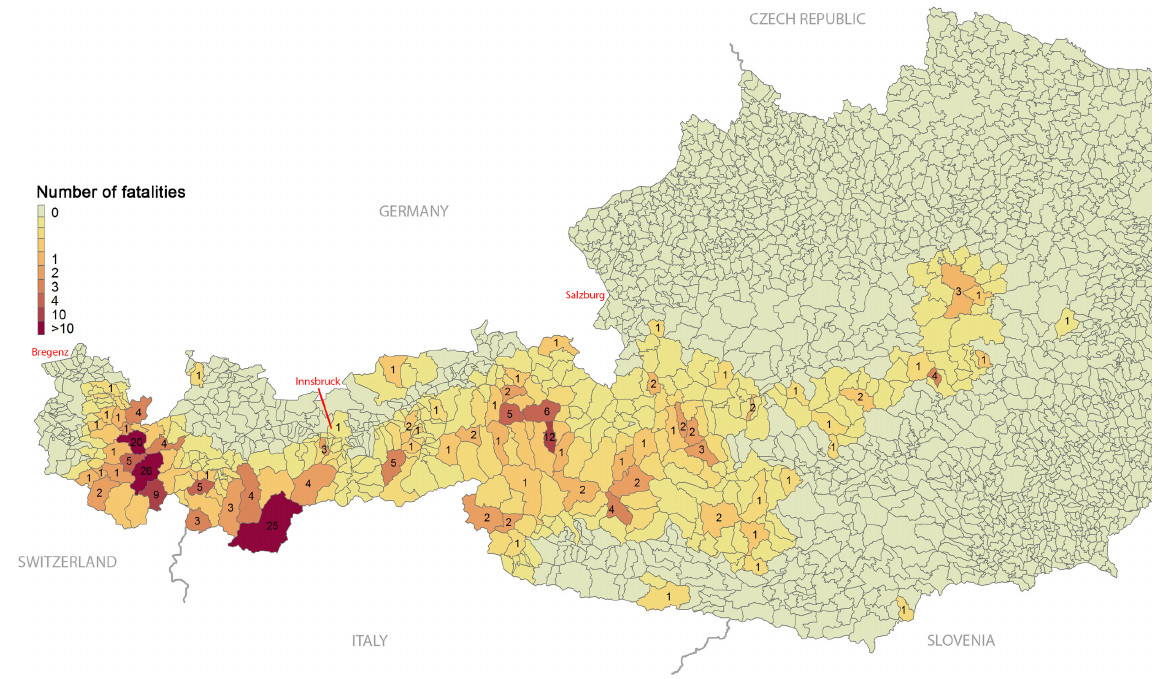
Figure 9. Regional distribution of avalanche fatalities (off-piste and backcountry) in Austria within 1980/1981–2015/2016.